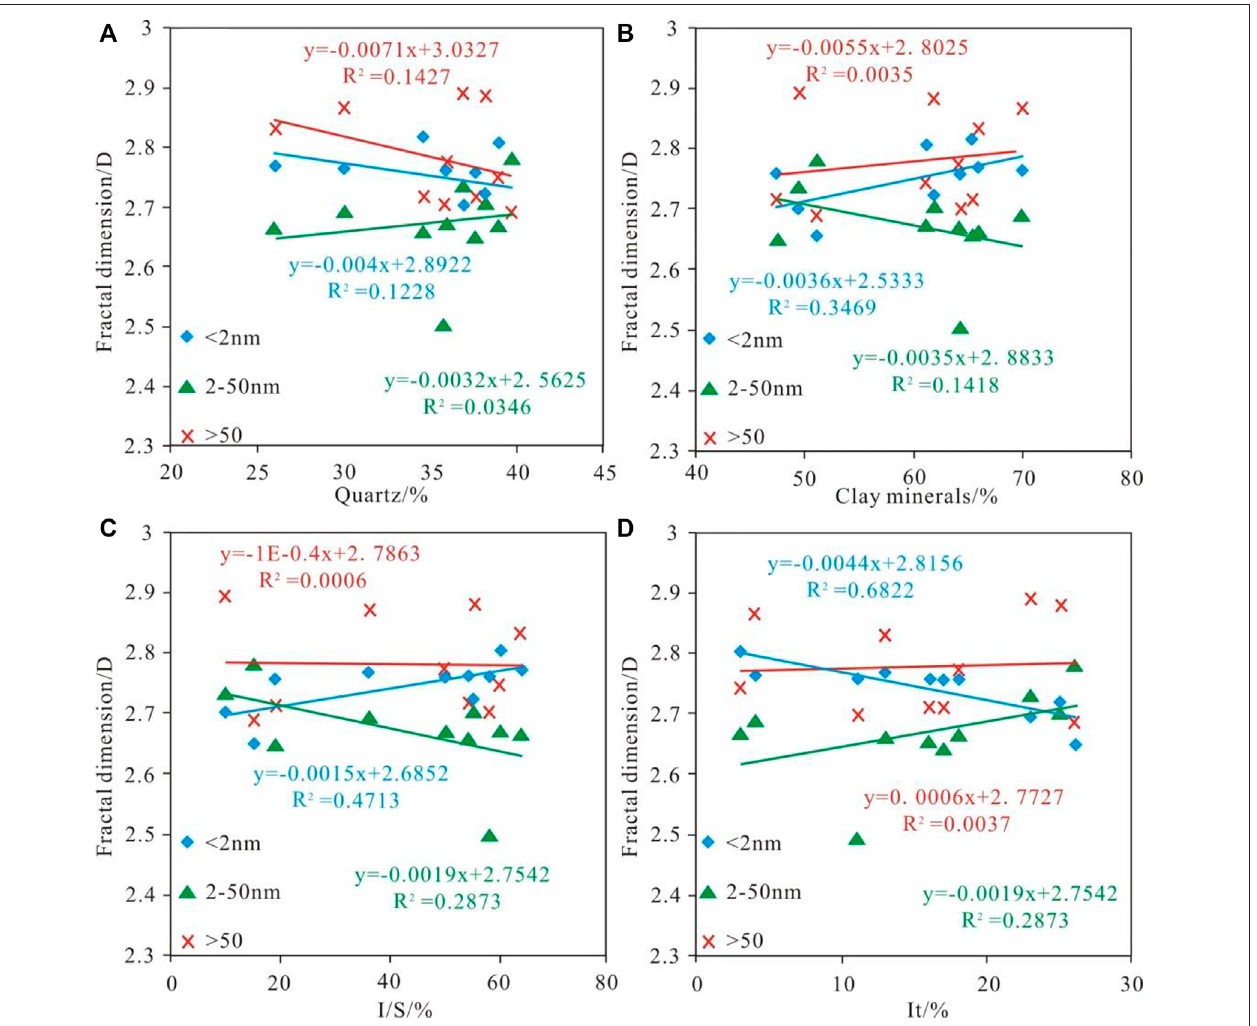
FIGURE 19 | The relationship of fractal dimension with detrital minerals and clay minerals. relationship between fractal dimension and (A) quartz, (B) clay minerals, (C) I/S and (D) It.